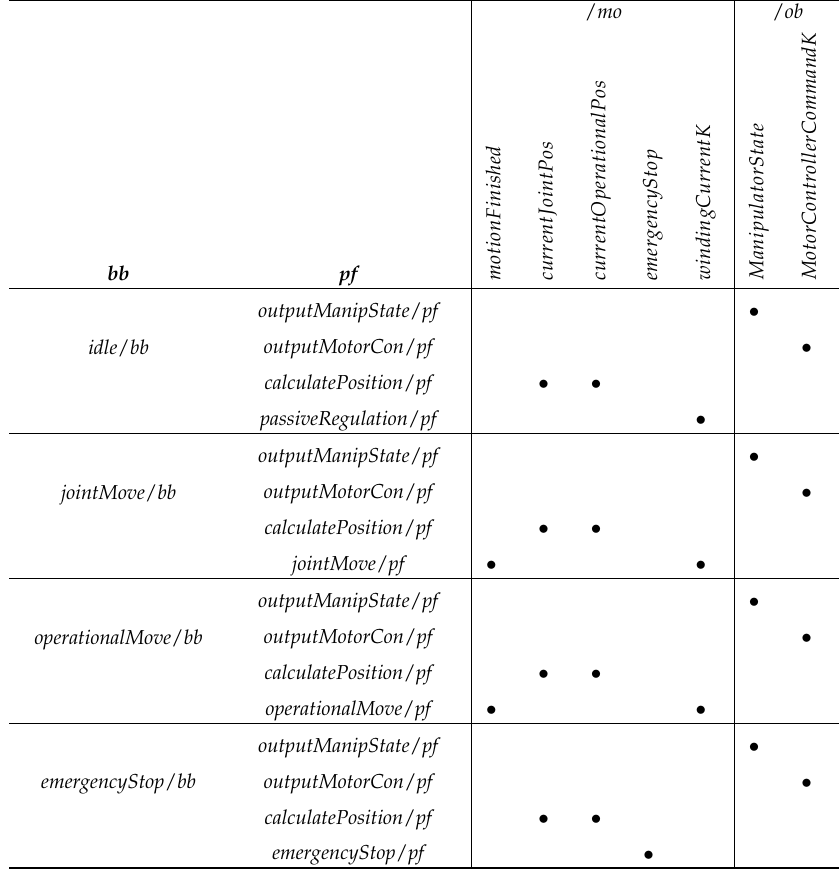
Table 7. Compositions of Transition Functions manip / a . cs . bb . tf . pf . The right part of the table presents what parts of output buffers and internal memory are produced by the specific Partial Transition Functions.